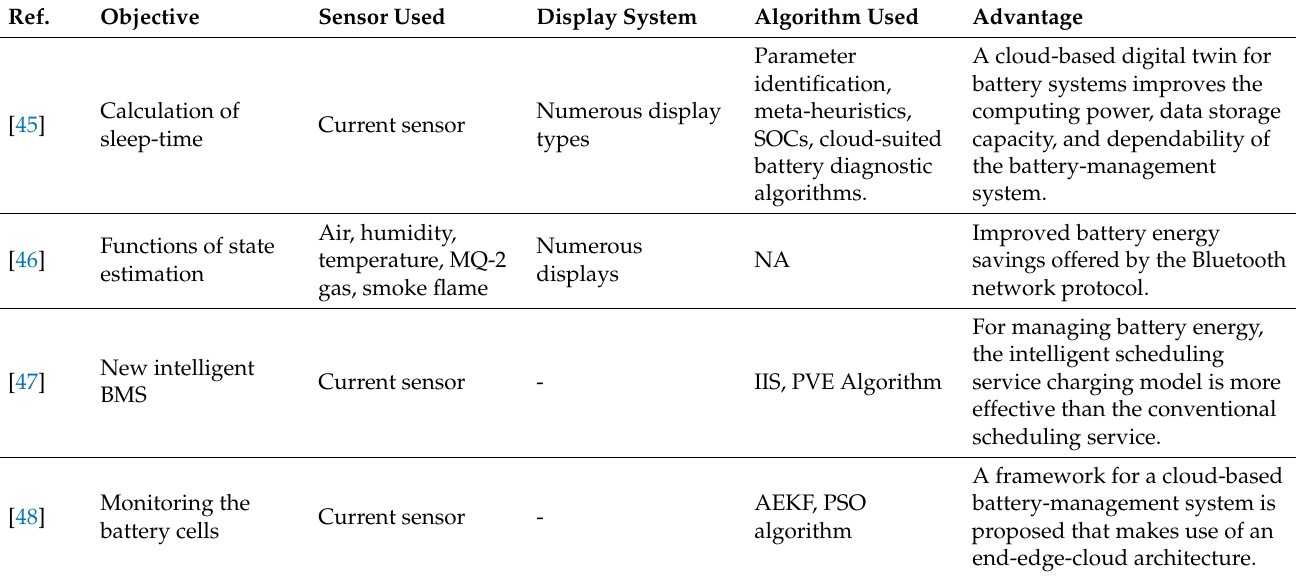
Table 4. A survey on cloud computing in battery-management